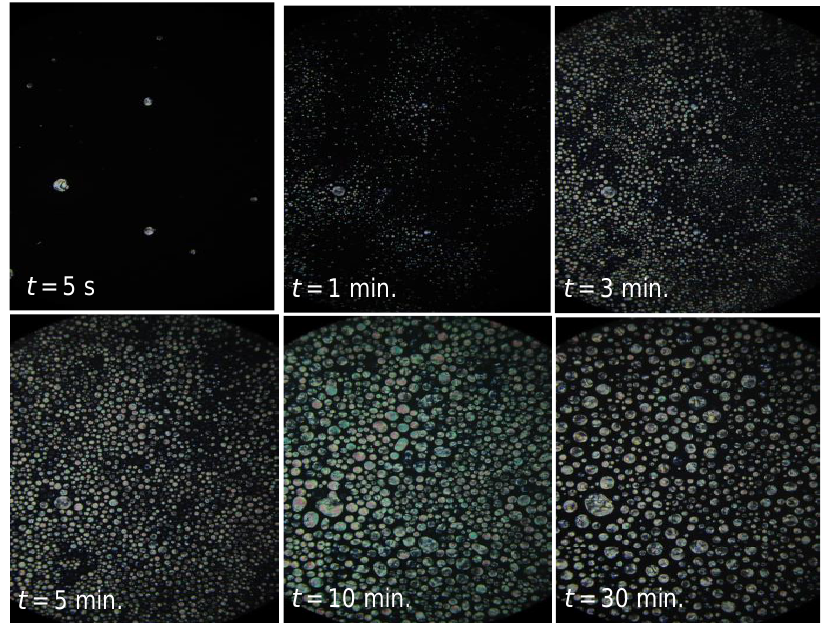
Figure 4. The time-dependent creation of coexisting phases in MBBA—Isooctane mixture two-phase ( 2P ) domain: 𝑥 = 0.1 𝑚𝑜𝑙 𝑓. isooctane, for the temperature 𝑇 2𝑃ℎ𝐼 − 1𝐾 . The photo for samples between two ‘polarizing’ flat glasses, distanced by 0.05 mm. Magnification 10x.